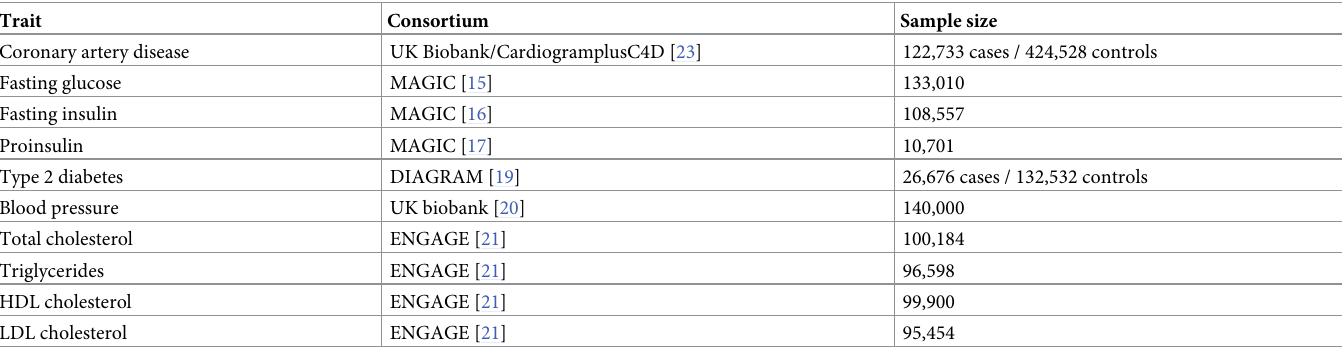
Table 2. Description of GWAS meta-analysis on cardiometabolic disorders.